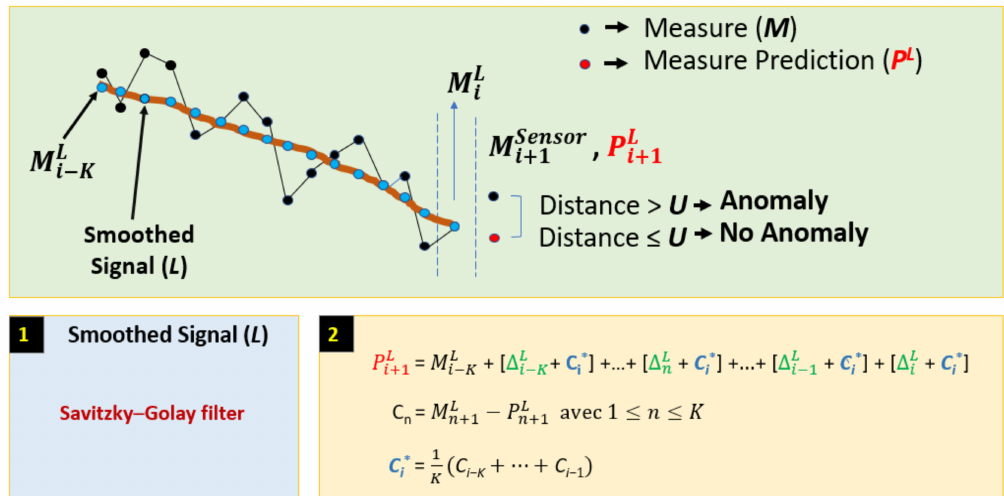
Figure 7. NADCA-O: Generalization of NADCA for anomaly detection and correction in signals with